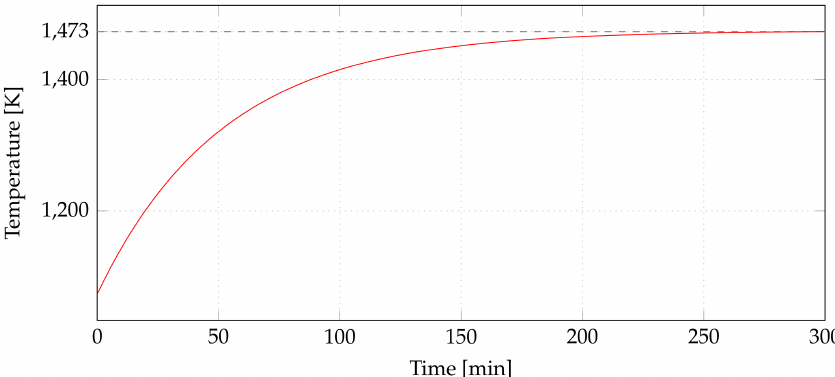
Figure 8. Evolution of the reactor’s temperature in case of a closed aperture and an oxygen flow rate = 1.465th − 1 , and the initial temperature is 1073K). f in oxygen = 0.88th − 1 ( f in biomass